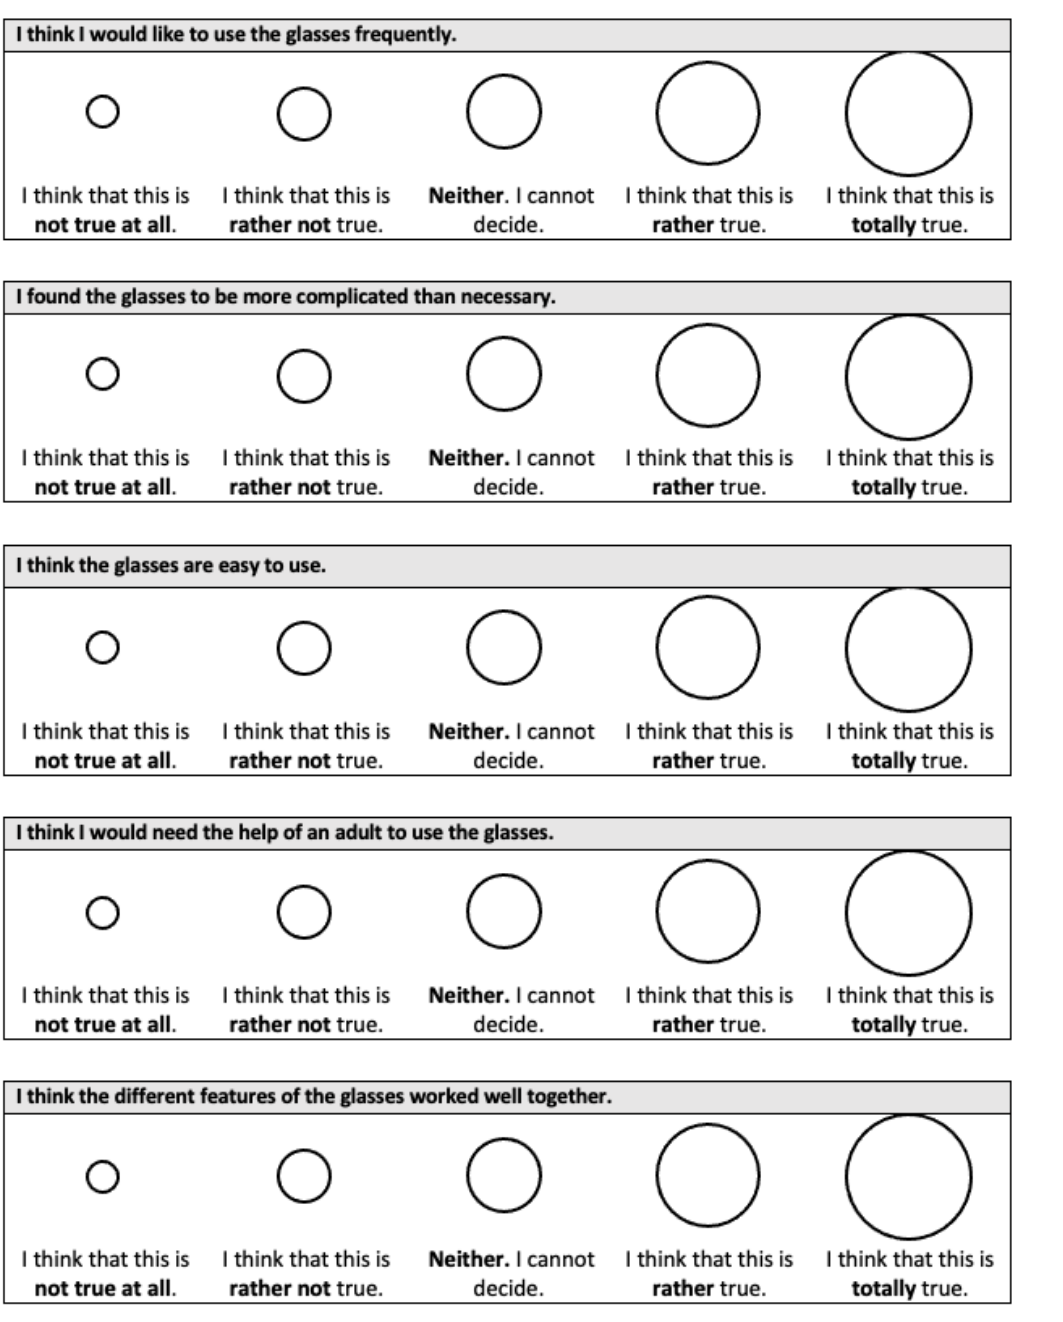
Figure A3. Questionnaire for device usability assessment (page 1).